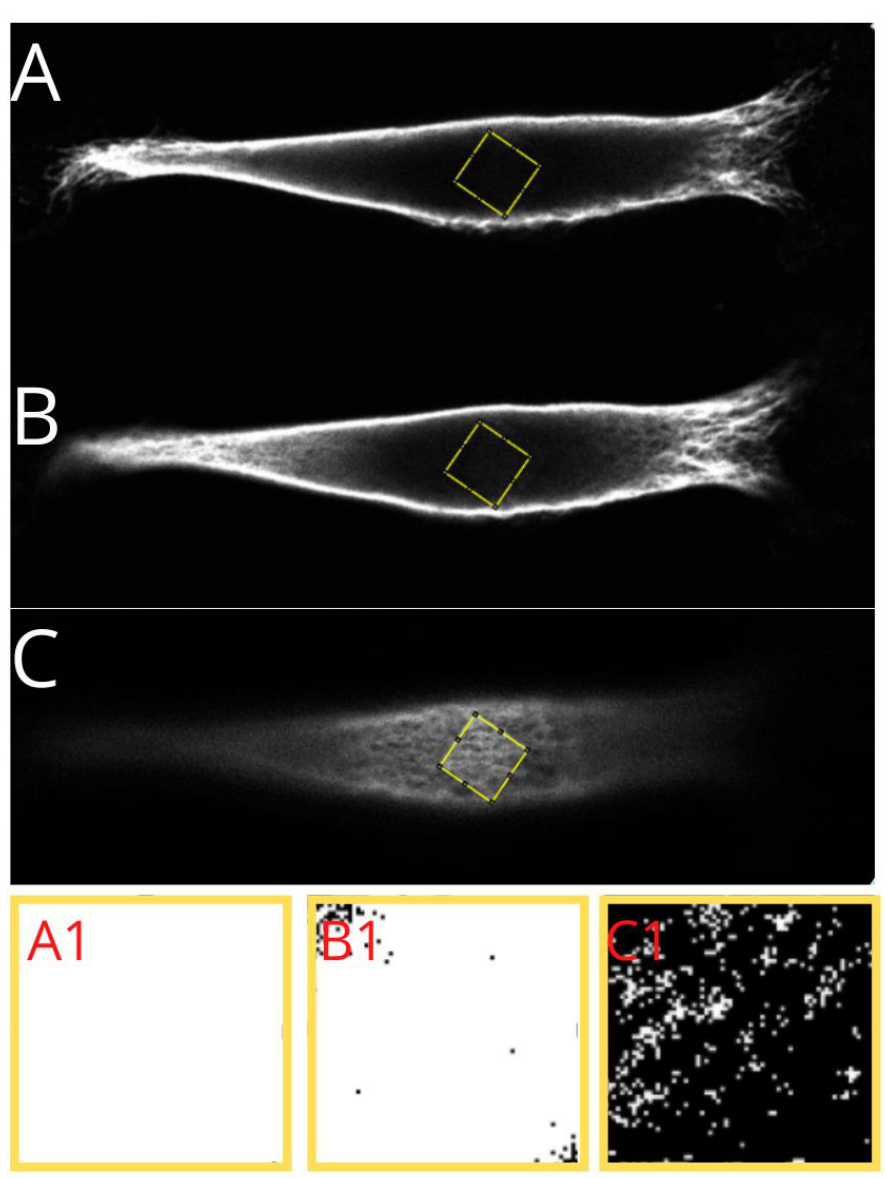
Figure 6. Presentation of a step performed in analysis of vimentin cytoskeleton. Identification of the regions under the nucleus ( A ), in the middle of the cell height ( B ), and above the nucleus ( C ), and the threshold areas in magnification, respectively ( A1 , B1 , C1 )—presenting the identified actual amount of vimentin in selected regions.